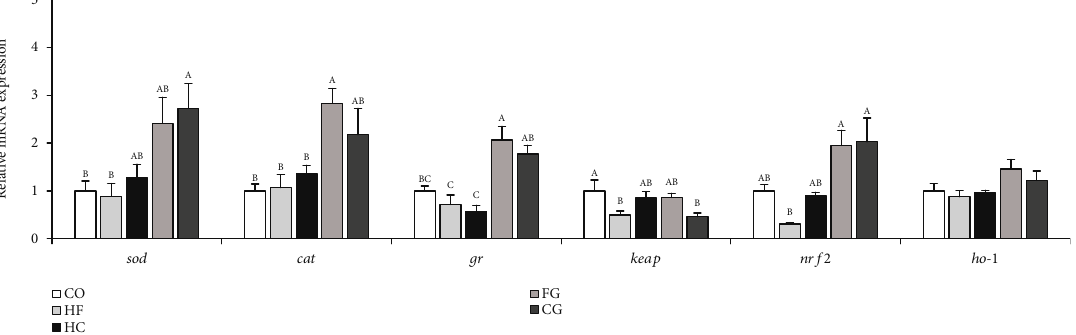
Figure 5: Expressions of the genes related to antioxidant in the liver of common carp fed di ff erent experimental diets. Values are means ± S : E : per diet in triplicate tanks ( n = 6 ). The di ff erent letters indicate the di ff erences between diets (one-way ANOVA, Duncan ’ s test, P < 0 : 05